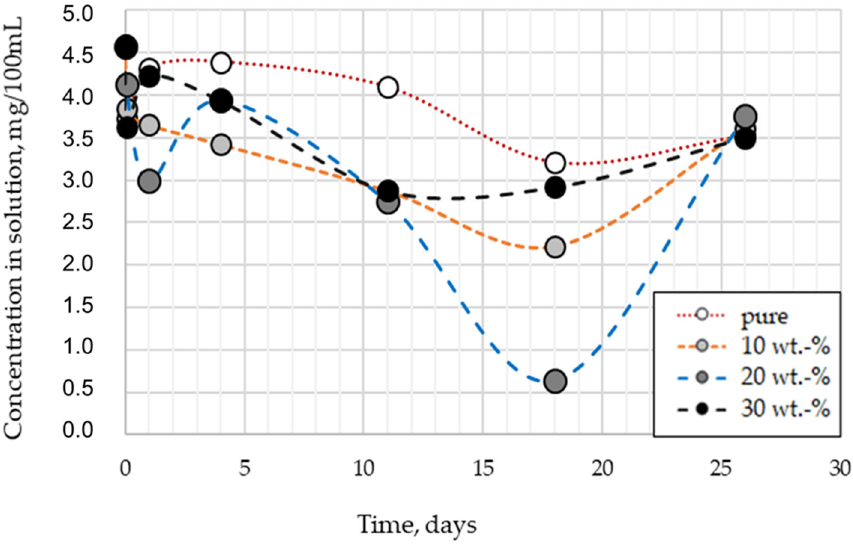
Figure 4. Sorption of IBU into Matrimid loaded with TS-1 zeolite.